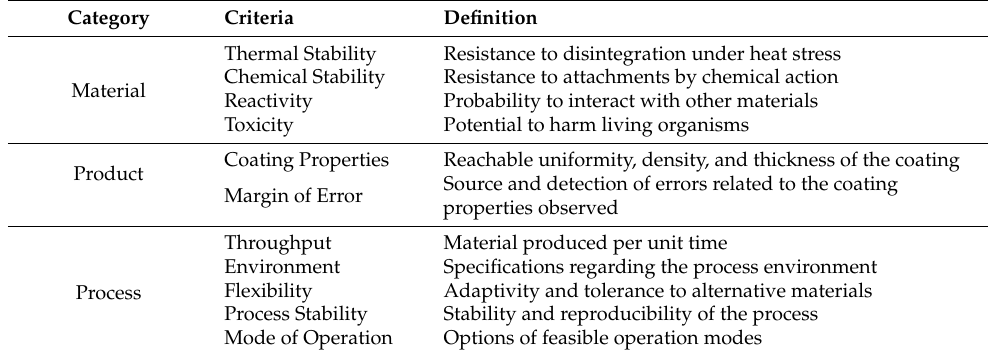
Table 6. Criteria and Definitions for the Technical Assessment.